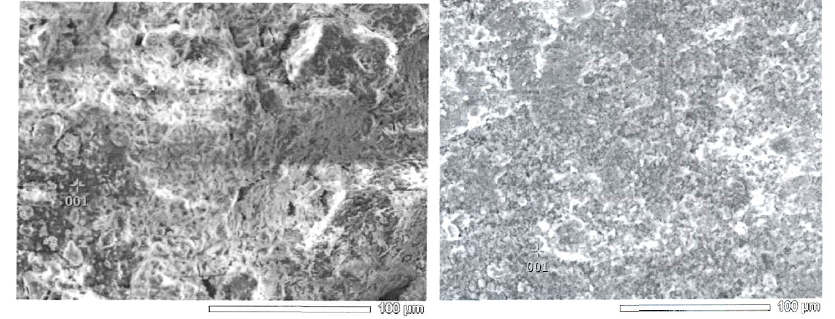
Fig. 10. The microstructure: a) experimental and b) control soil-concrete samples made on the basis of sludge with a concrete additive ( × 500)